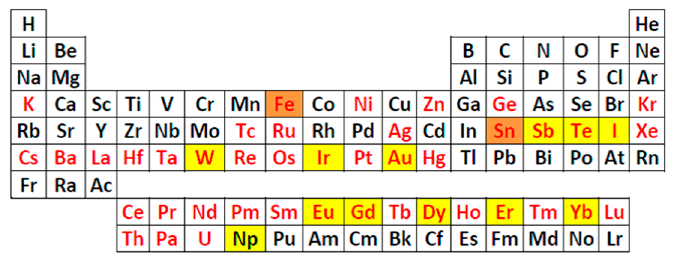
Figure 7. Elements (in red) of the periodic table for which a Mössbauer isotope has been observed. The most used are highlighted with a yellow background, which is orange for the most “popular” Fe and Sn.